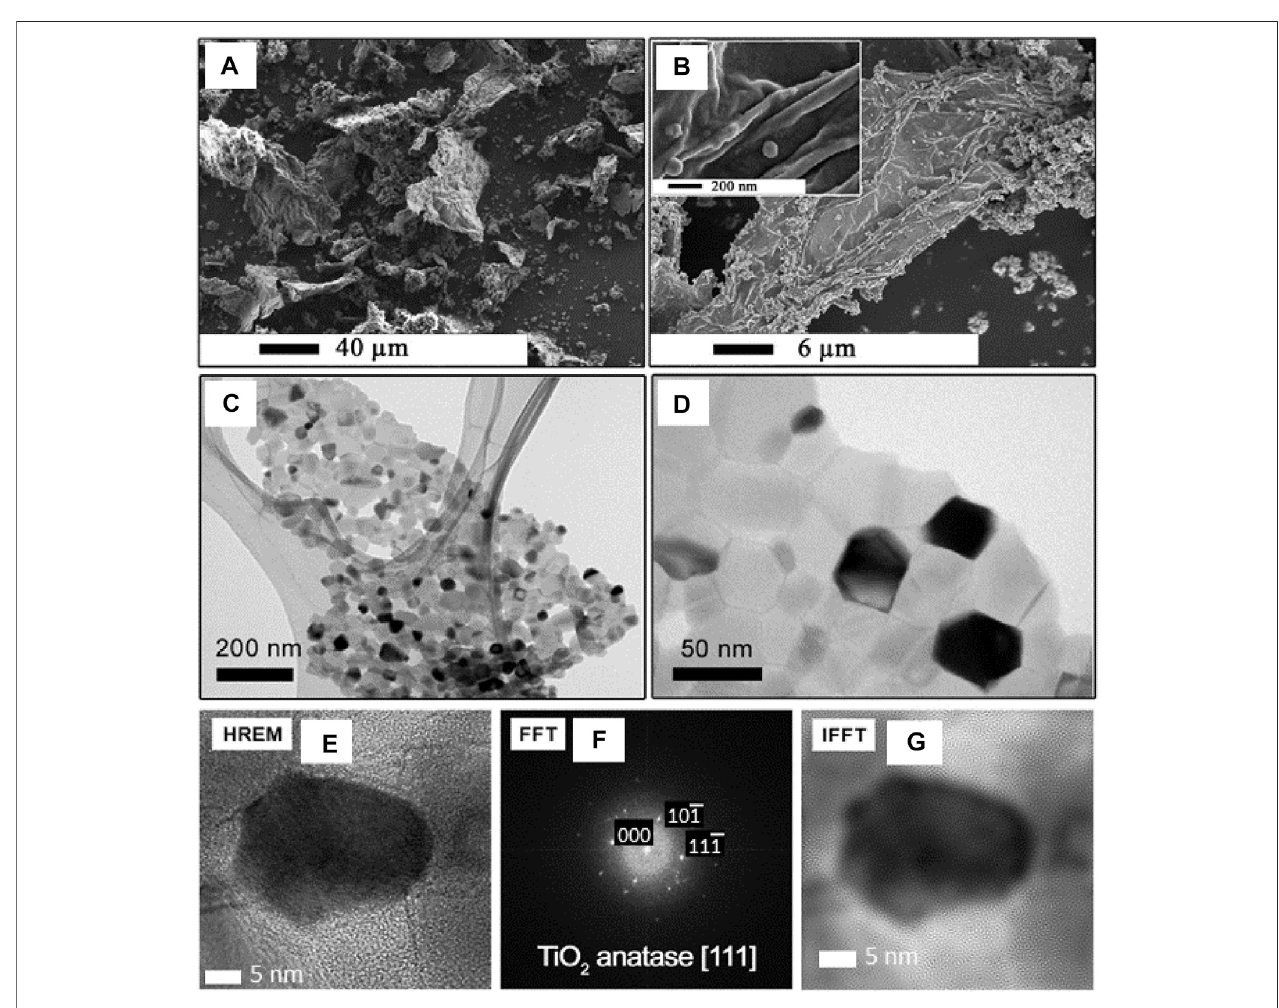
FIGURE9| Themorphology (A , B) andstructure (C – F) oftheRGO/TiO 2 (40 wt%)nanocompositeobtainedusingthesimpli fi edsol-gelmethodanalysedwithSEM and HREM analysis. The structure of TiO 2 NPs was analyzed using electron diffraction (F) and corresponding IFFT imaging (Reproduced with permission from (Jastrzebska et al., 2016) with minor